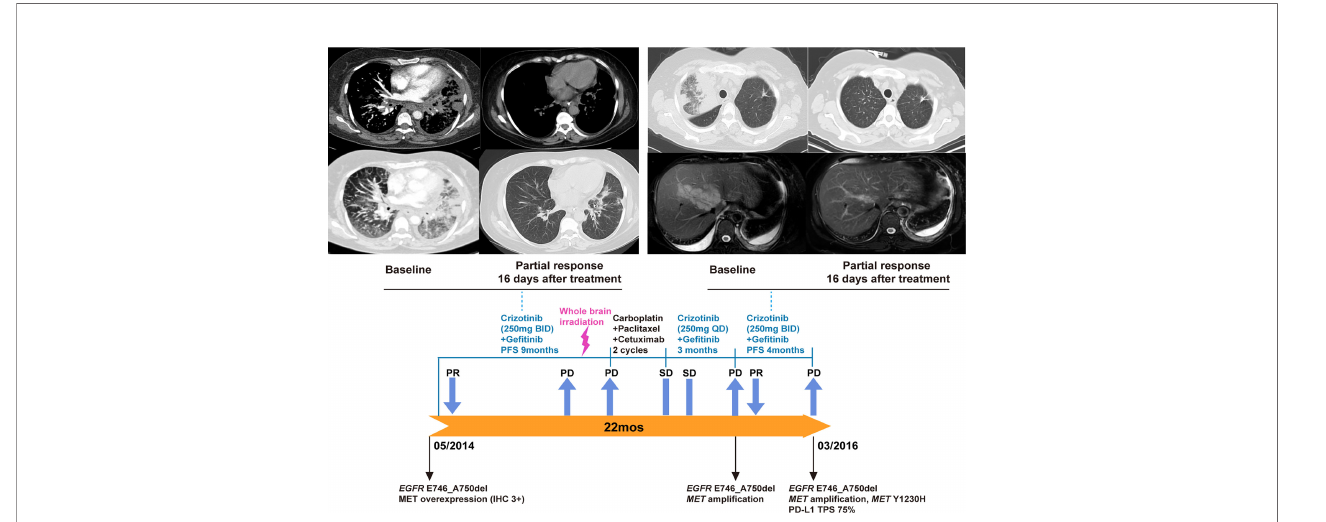
FIGURE 2 | Ge fi tinib plus crizotinib treatment and rechallenge for EGFR -mutated NSCLC with MET overexpression/ampli fi cation. Based on the result of MET overexpression, the patient began ge fi tinib plus crizotinib. A partial response was observed 16 days after the initiation of this combination therapy (upper left panel). After disease progression, therapy was changed to chemotherapy plus cetuximab for two cycles. Due to chemotherapy-related toxicity, the patient was rechallenged with ge fi tinib plus crizotinib (reduced dose, 250 mg QD) with stable disease. Upon the development of new liver metastases, molecular testing of a biopsy con fi rmed concurrent EGFR mutation and MET ampli fi cation. Crizotinib dose was then increased to 250 mg BID (lower panel). Another partial response was observed 16 days after the crizotinib dose increase (upper right).